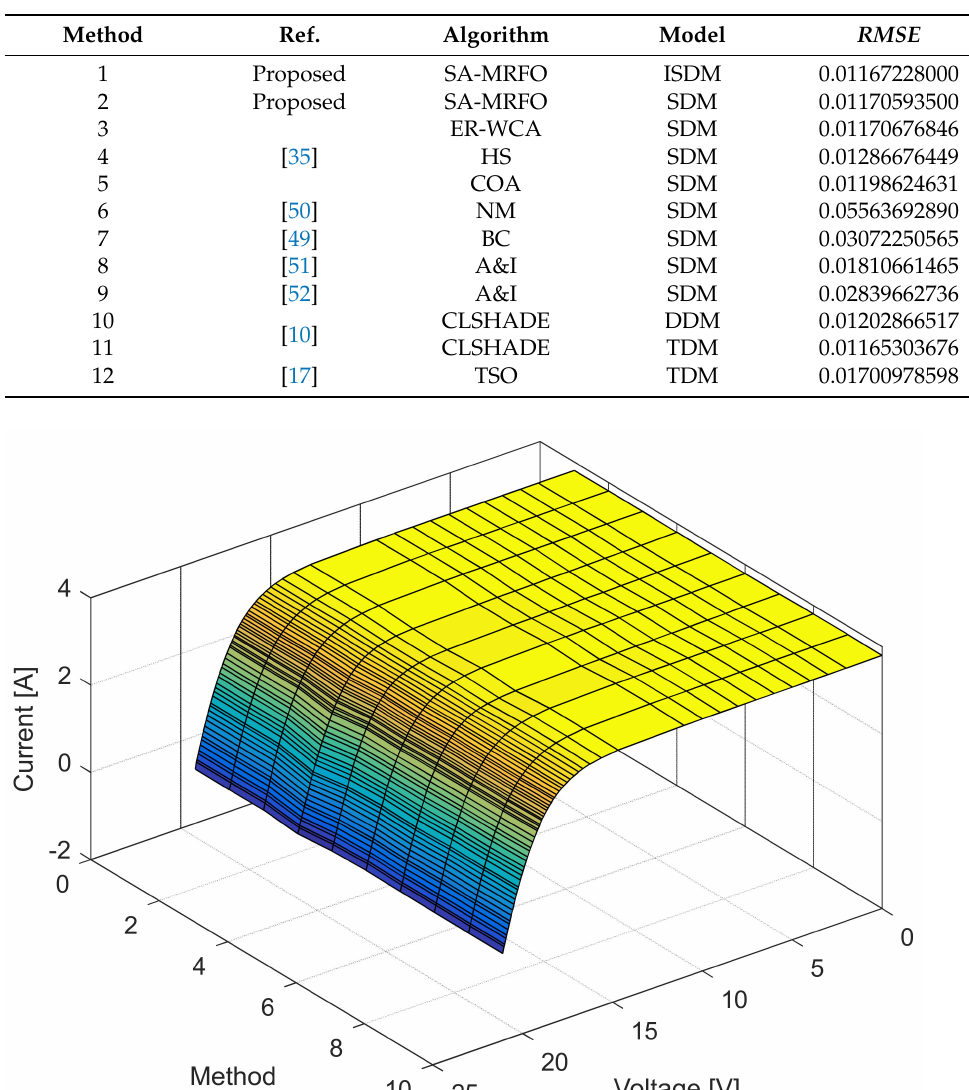
Table 5. RMSE calculation for Solarex MSX 60 module using various algorithms.